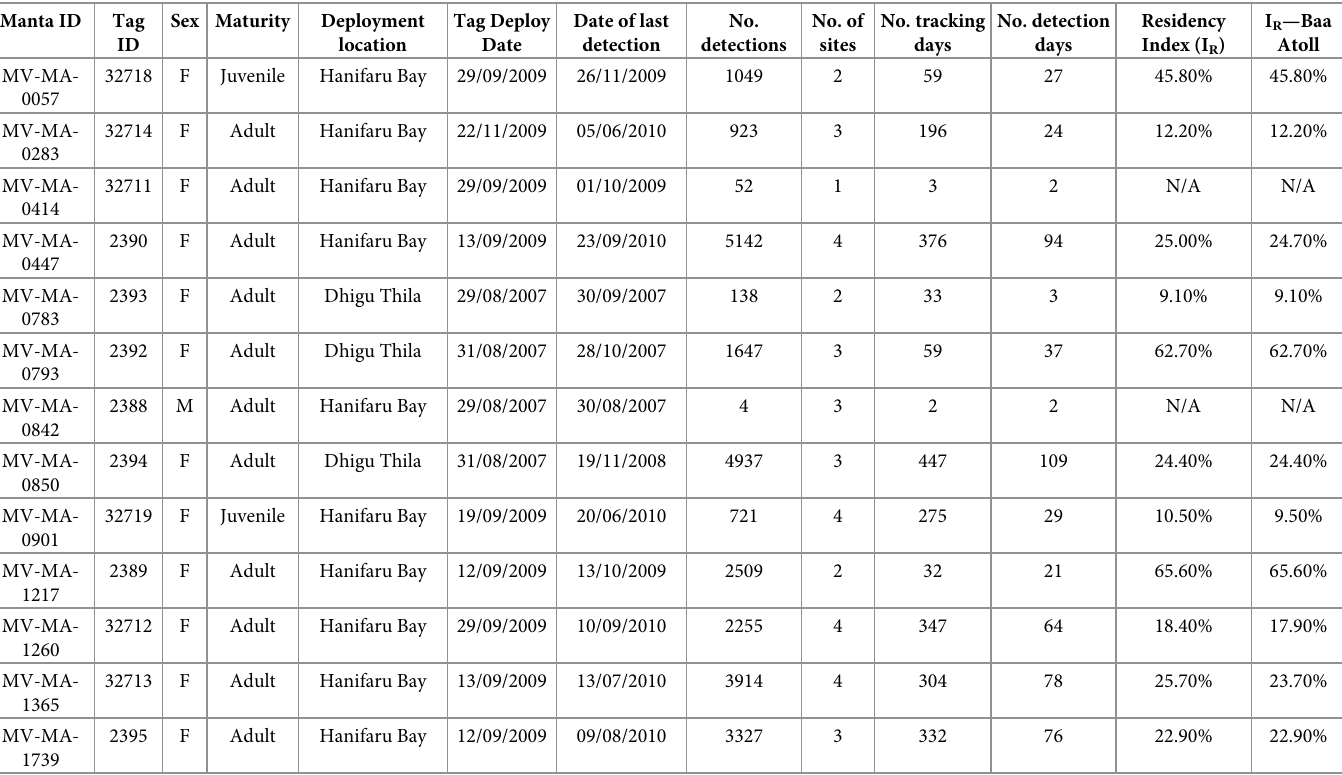
Table 1. Acoustic tag deployment summary.